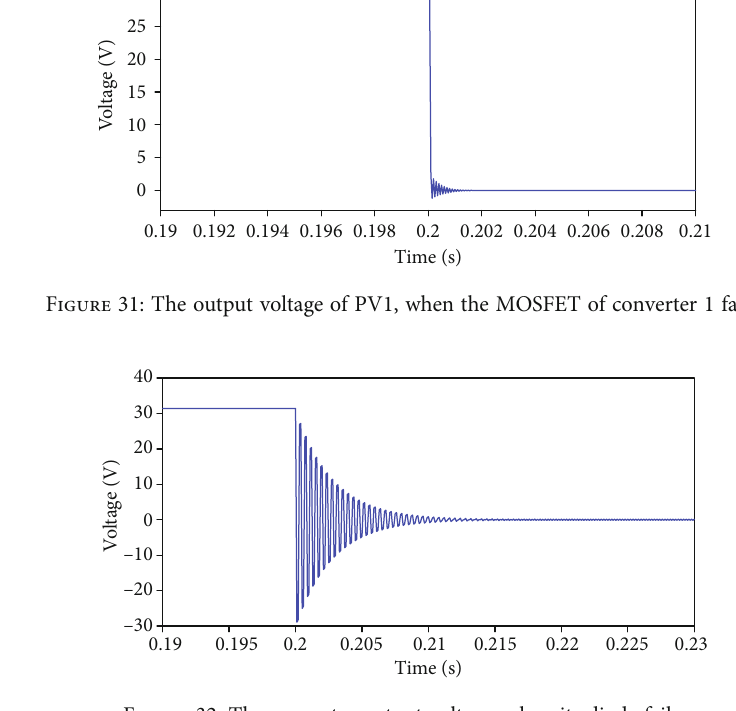
Figure 32: The converter output voltage, when its diode fails.